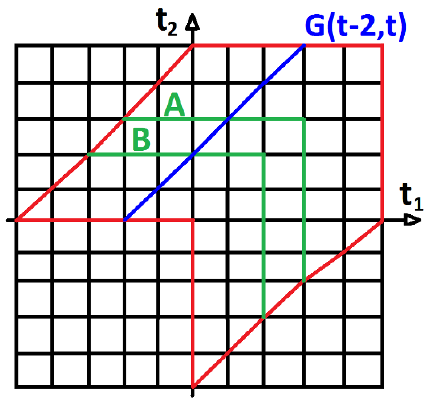
Figure 3. The red lines mark the grid used for solving the Kadano(cid:11)-Baym equations. This corresponds to ignoring terms on the top left of the second quadrant and the bottom right of the fourth quadrant where the values of G > ( t 1 ; t 2 ) are